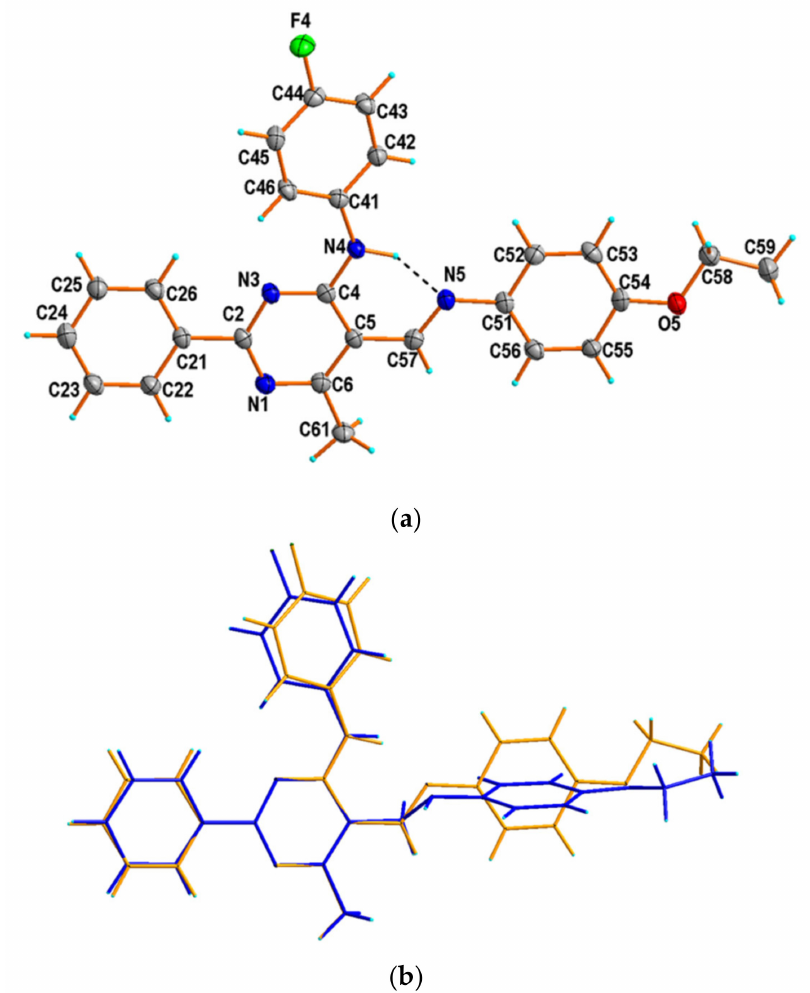
Figure 4. ( a ) X-ray molecular structure of 3 with the atom-numbering scheme. Displacement ellip- soids are drawn at the 50% probability level. H atoms are shown as small spheres of arbitrary radii. The dashed line (in black) indicates the intramolecular N–H · · · N hydrogen bond. ( b ) Overlapping in the structure of 2 (in blue) and 3 (in light orange); the common reference points are N1, C2, N3, C4, C5, and C6 atoms of the pyrimidine